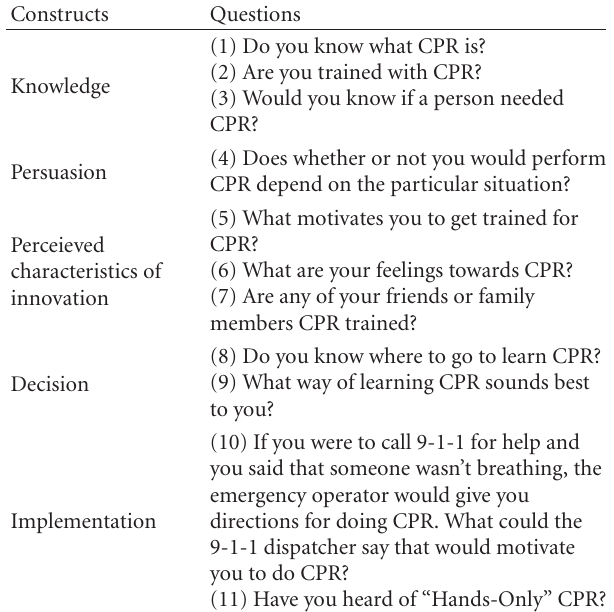
Table 1: Examples of focus group questions based on the innova- tion-decision